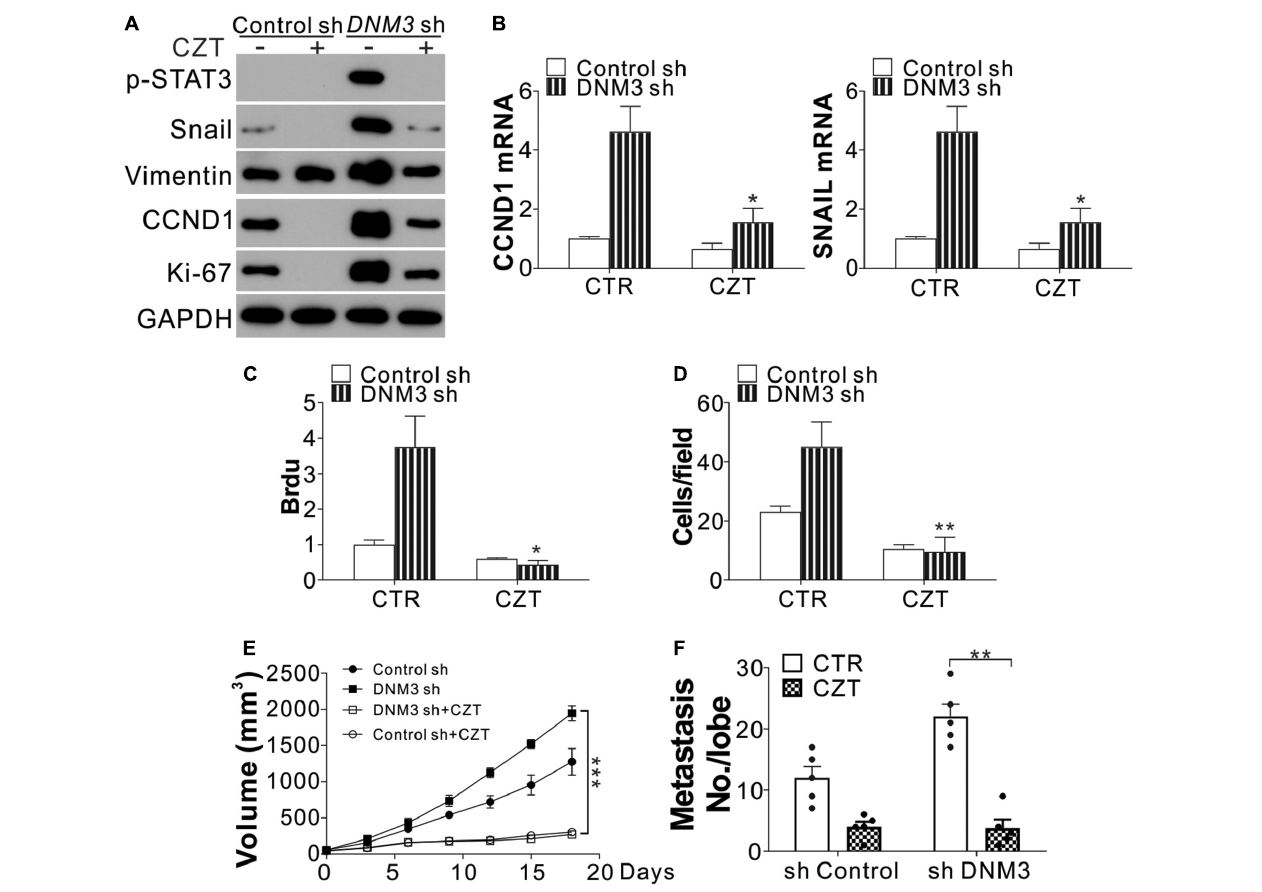
FIGURE 6 | The c-MET inhibitor has tumor suppressive effects on DNM3-depleted lung cancer cells and tumors. (A–D) H1299 cells with or without stable DNM3 knockdown were treated with 10 µ M crizotinib (CZT) for 24 h. (A) Western blot assay of the expression of the indicated proteins. (B) RT-qPCR assay of the mRNA levels of CCND1 and SNAI1 . (C) Brdu assay of cell proliferation. (D) Transwell assay of the migration of the cells. (E) Nude mice xenografted with H1299 cells with or without stable DNM3 knockdown were treated with CZT (35 mg/kg per day for 12 days) by oral gavage ( n = 5 for each group). The tumor growth was monitored. (F) Nude mice ( n = 5 for each group) injected via the tail vein with H1299 cells with or without stable DNM3 knockdown were treated with CZT (35 mg/kg per day for 12 days) by oral gavage ( n = 5 for each group). The number of metastatic tumor nodules in the lung was counted. Experiments for (A–D) were repeated 3 times. * p < 0.05; ** p < 0.01; *** p <